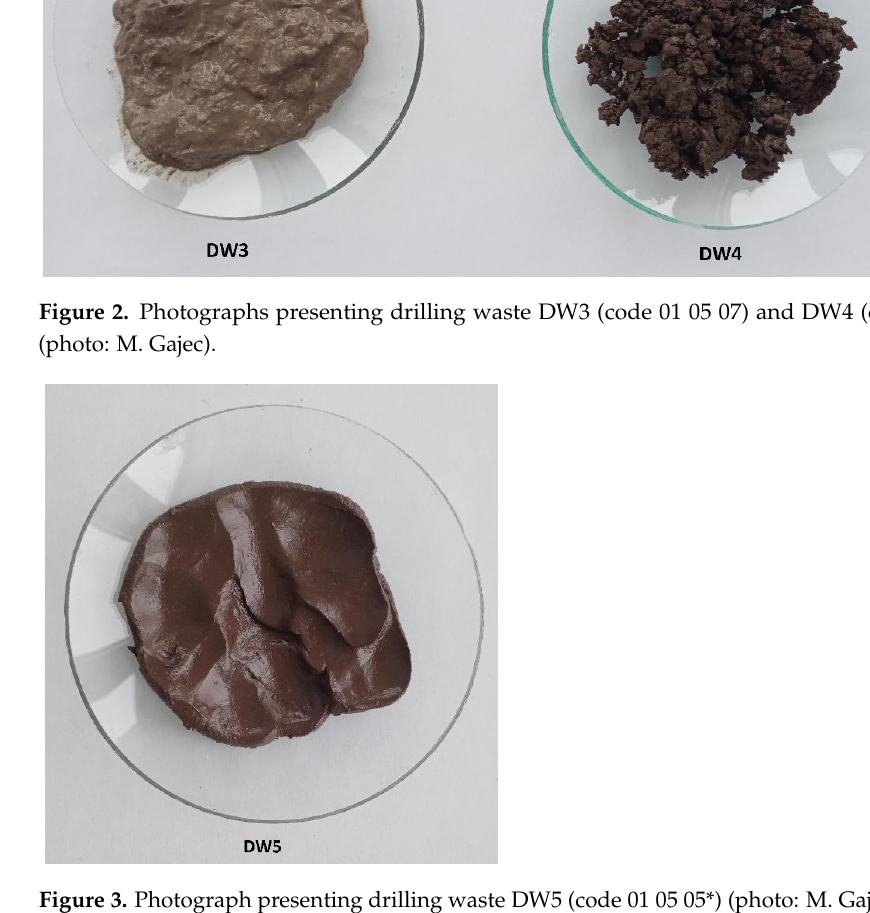
Figure 3. Photograph presenting drilling waste DW5 (code 01 05 05*) (photo: M. Gajec). The studied drilling wastes were assigned the appropriate waste codes from Table